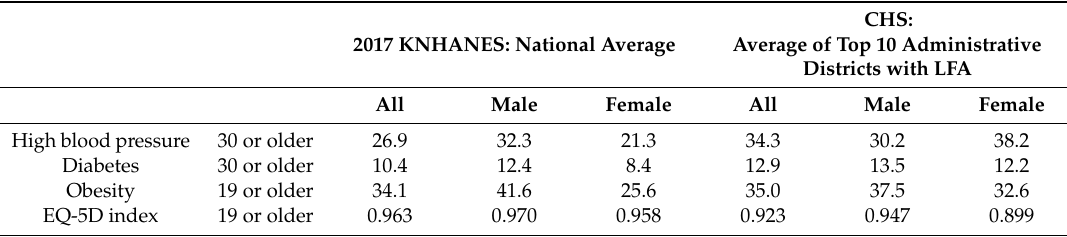
Table 10. Diseases related to dietary life and EQ-5D index.